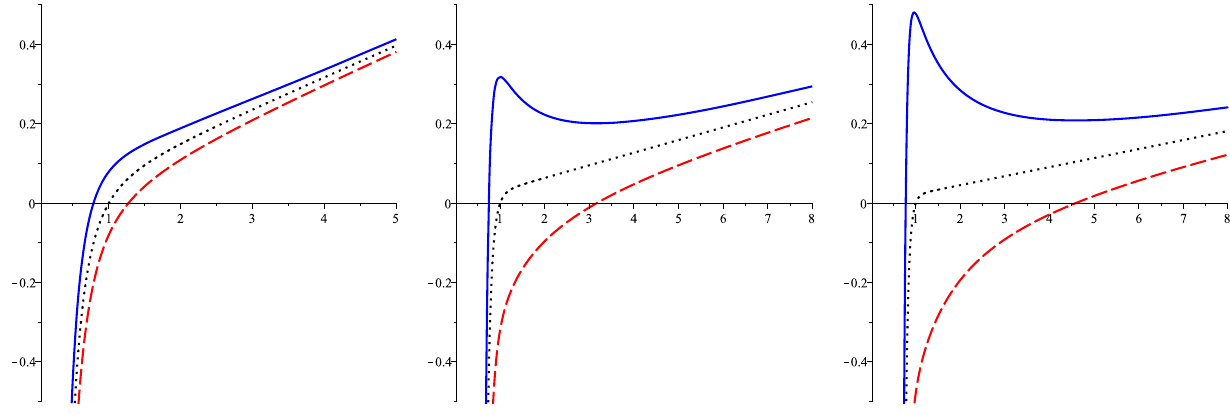
Fig. 1 T versus r + for q = 1, P = 1 / 8 π , k = + 1 (solid lines), k = 0 (dotted lines) and k = − 1 (dashed lines). d = 4 (left panel), d = 7 (middle panel) and d = 9 (right